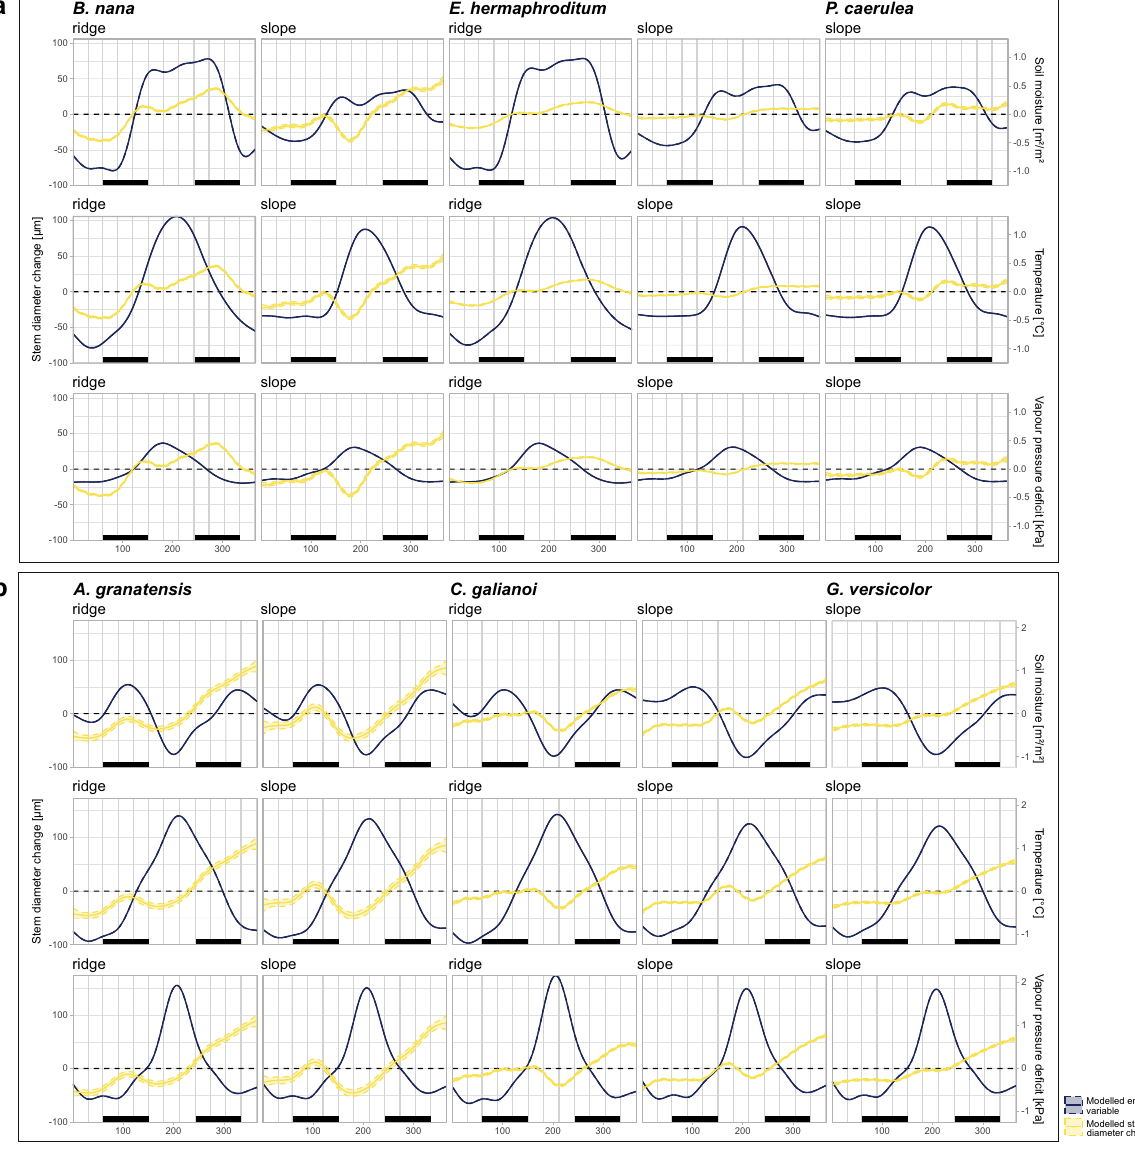
Fig. 4 Modelled intra-annual stem diameter change and environmental variables (soil moisture, temperature and vapour pressure de fi cit). Each parameter was modelled from raw hourly measurements using generalized additive models (GAMs), including sampling site and year as random effects. Bars at the bottom of each graph show meteorological seasons. The tundra species are presented in a while b shows the Mediterranean